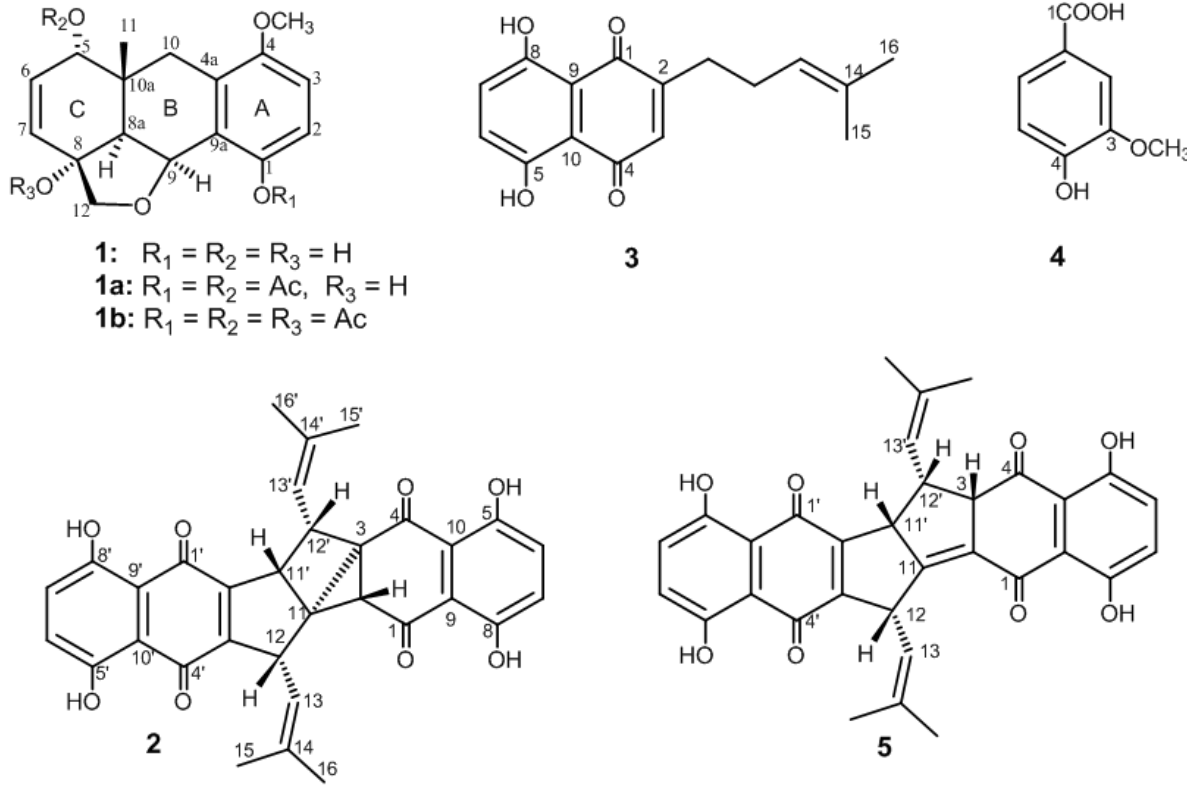
Figure 1. Phenolic constituents ( 1 – 4 ) isolated from A. hispidissima roots and shikometabolin D ( 5